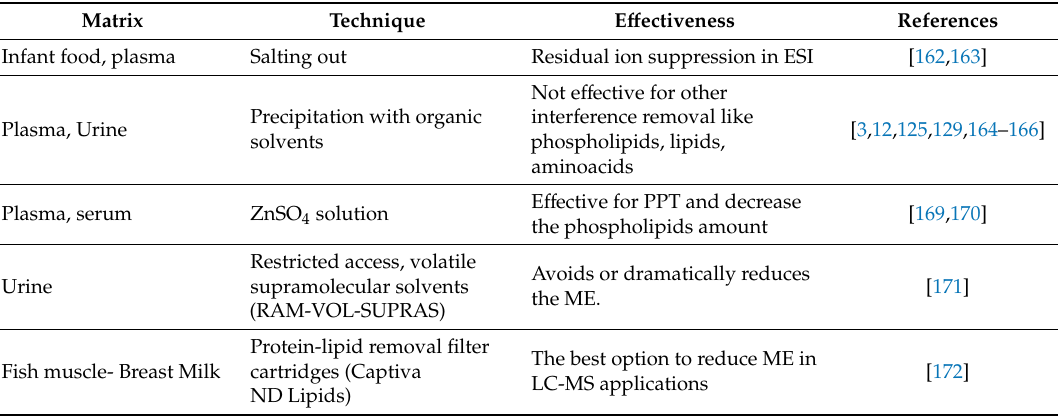
Table 4. List of the protein removal (PPT)